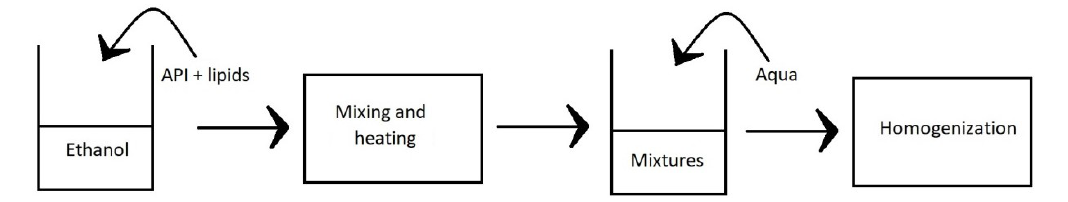
Figure 5. The cold method.